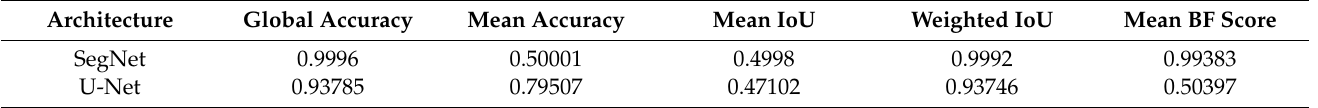
Figure 14. The performance of the trained semantic segmentation model in both correct and false detected potentially damaged areas, based on U-Net architecture; red pixels are detected segments of the joint opening. Table 3. Accuracy metrics of both trained